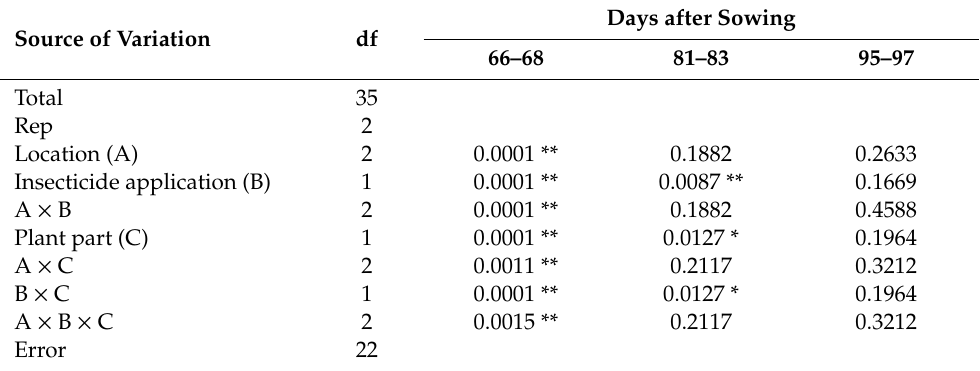
Table 5. Imidacloprid residues in di ff erent plant parts during the vegetation period in 2015.